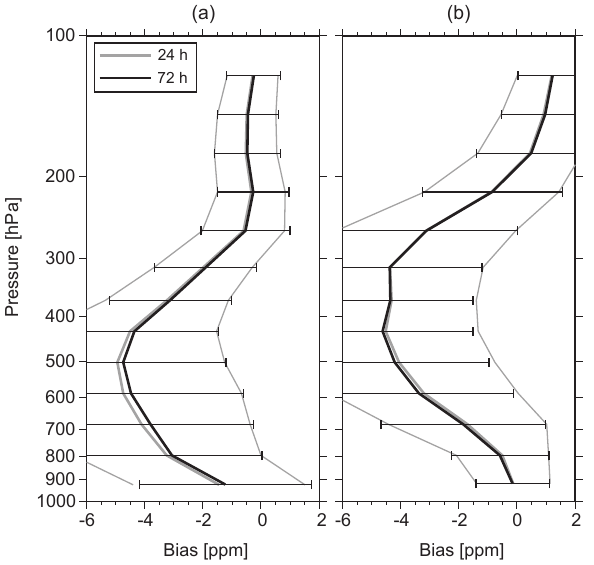
Figure 4. Bias profiles of GOSAT/TANSO-FTS TIR CO 2 data against CME_AK CO 2 data over Narita airport (Japan) using co- incident pairs with 24h (gray) and 72h (black) time difference cri- teria: (a) winter (JF) 2010 and (b) summer (JJA)